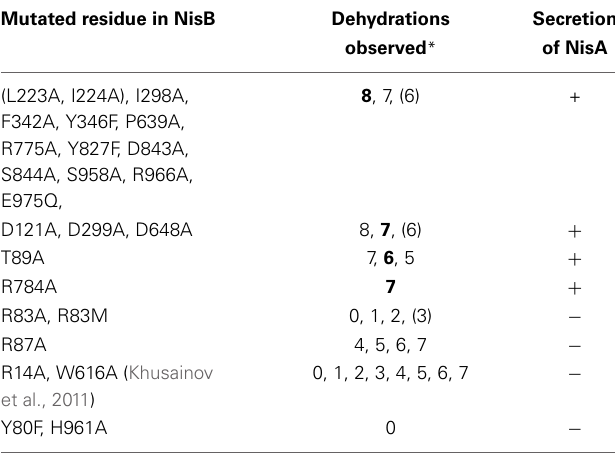
Table 1 | Dehydration pattern of precursor nisin modified by NisB